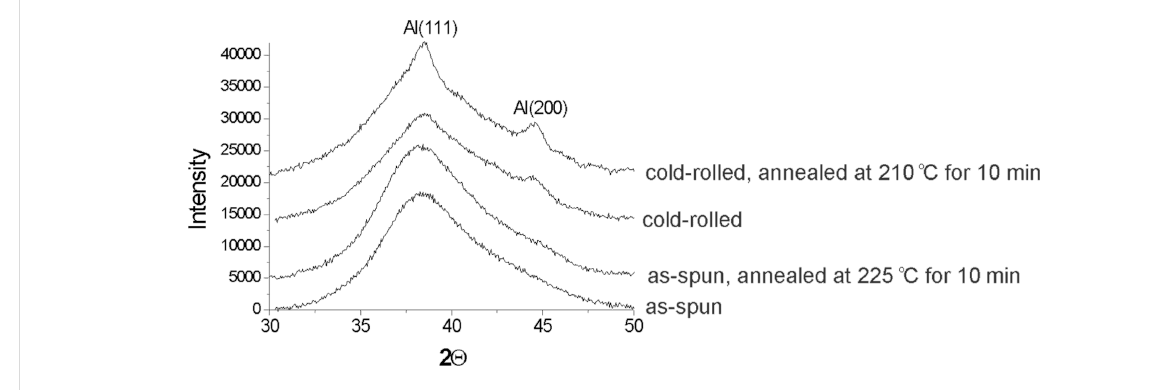
Figure 5: XRD results showing an increase in intensity of the Al peaks after annealing of a cold-rolled sample.